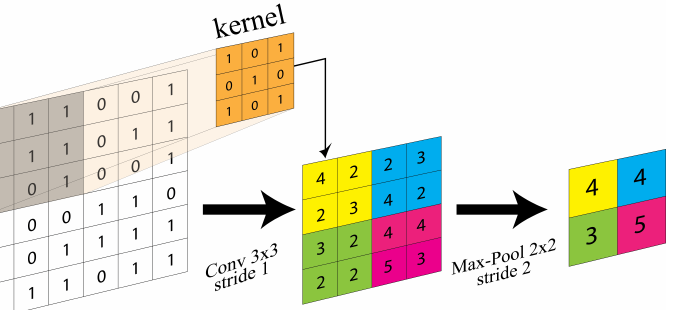
Figure 1. Convolution (kernel size 3 × 3 and stride 1) and Pooling (kernel size 2 × 2 and stride 1) layer